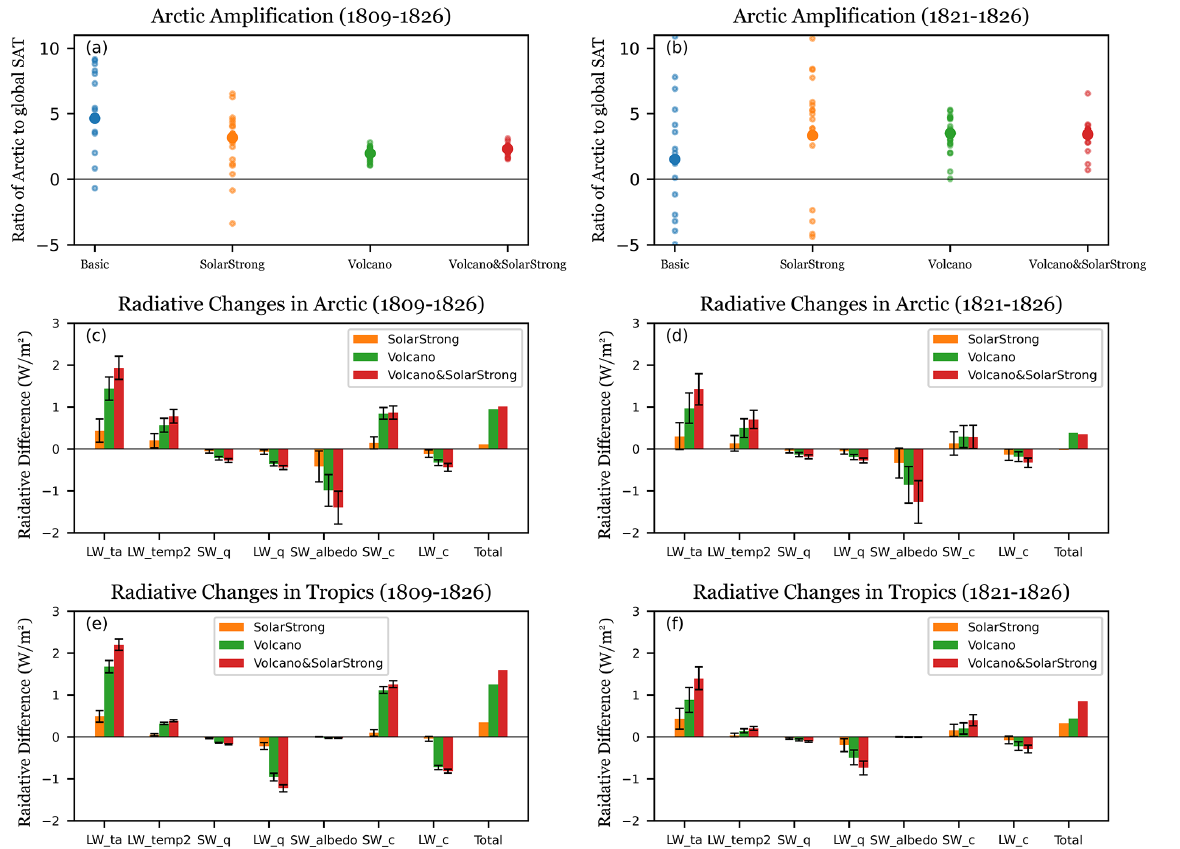
Figure 11. (a) Ratio of Arctic SAT anomalies (67 to 90 ◦ N) to global mean SAT anomalies over 1809–1826 for each ensemble in the Basic, SolarStrong, Volcano, and Volcano&SolarStrong experiment. The larger dot is the ensemble mean (ensemble mean Arctic SAT anomaly/ensemble mean global SAT anomaly). (b) 1821–1826. (c) The difference between the Arctic (67 to 90 ◦ N) radiative change (Wm − 2 ) of each experiment to the radiative change of the Basic experiment over 1809–1826. (d) 1821–1826. (e) and (f) are for the tropics (30 ◦ S to 30 ◦ N). The SW and LW mean shortwave and longwave radiation changes, respectively; and ta is air temperature difference; temp2 is surface air temperature; q is water vapor; albedo is albedo; c is cloud; total is the summation of the seven radiation